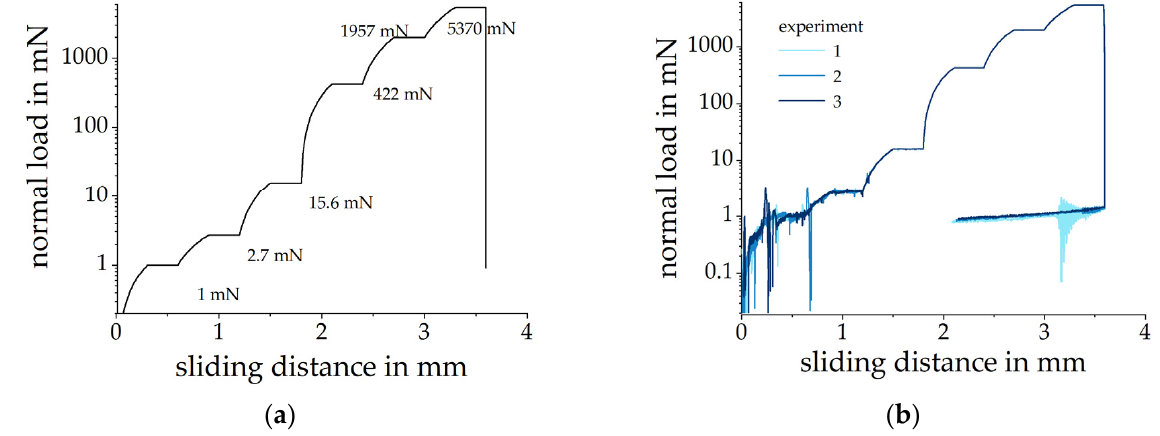
Figure 1. Normal load during the experiments: ( a ) load function; ( b ) normal load signals for the three experiments. The scratches were analyzed using white light interferometry (Contour GTK,